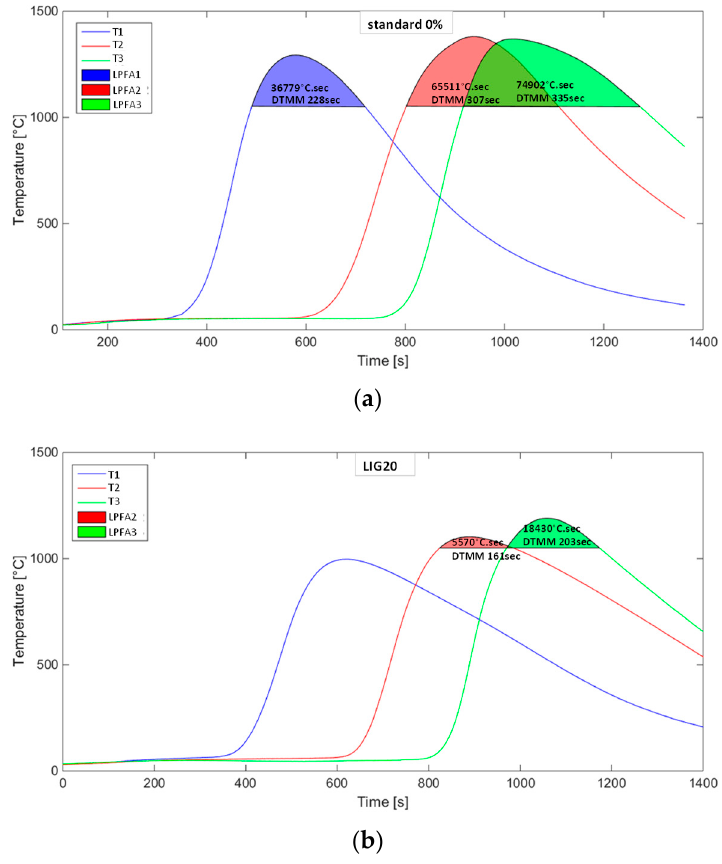
Figure 10. Temperature curves in measured horizons of the sintered layer: ( a ) without coke substitution, ( b ) 20% of coke substitution with lignin.